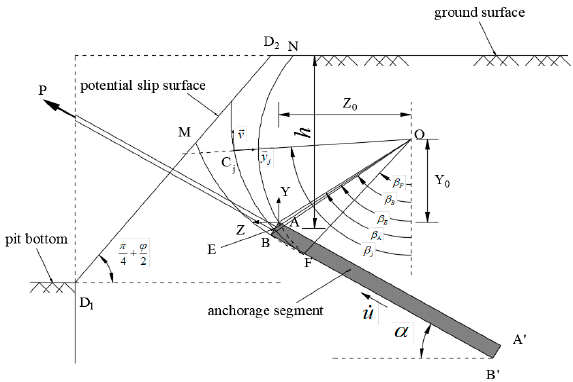
Figure 3. Failure model diagram.